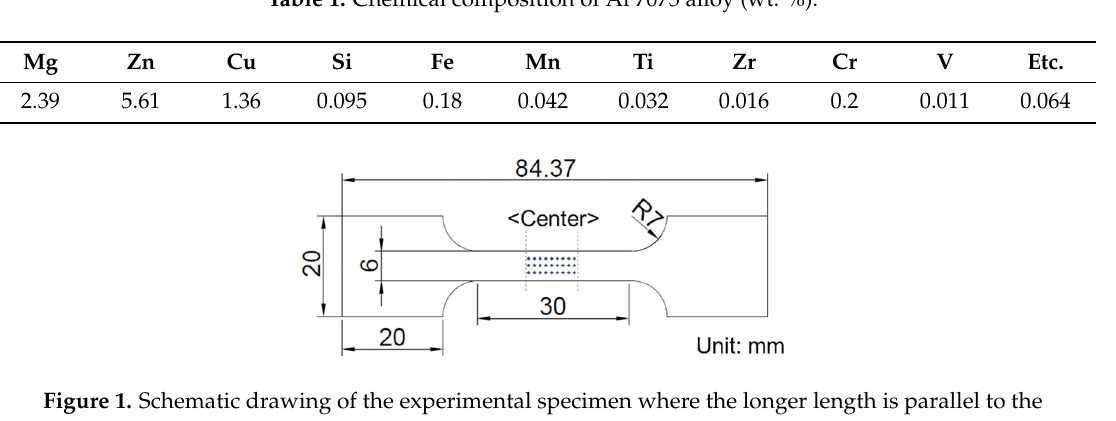
Table 1. Chemical composition of Al 7075 alloy (wt. %).